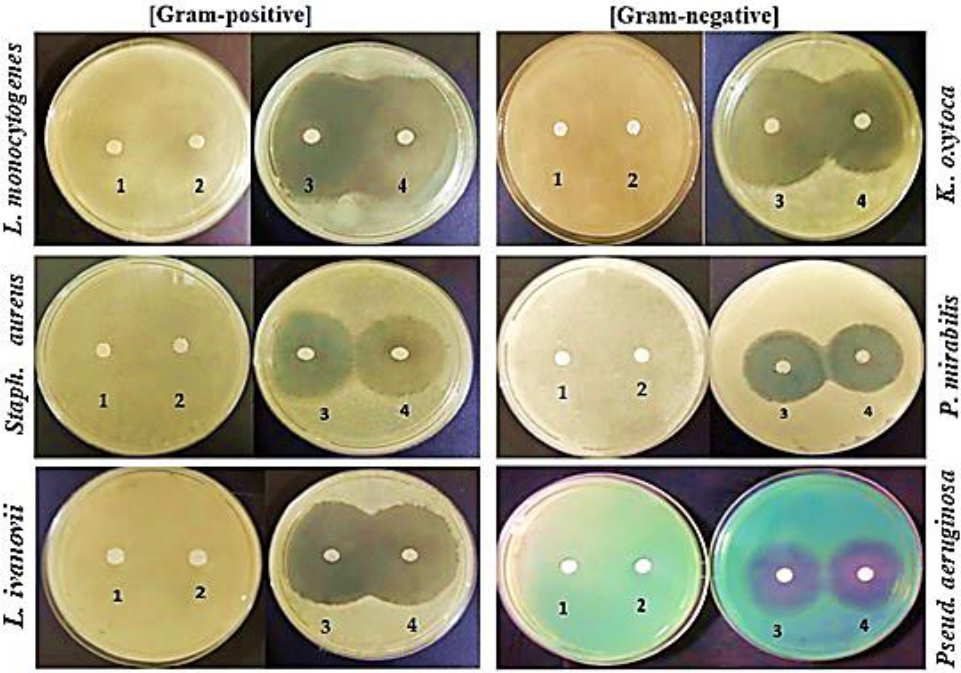
Figure 5. Initial testing of antibacterial activity of different lupine protein fractions of (1) LPI, (2) 7S globulin, (3) BS, and (4) 11S globulin tested at a concentration of 1000 µg/mL against Gram-positive and Gram-negative bacteria.